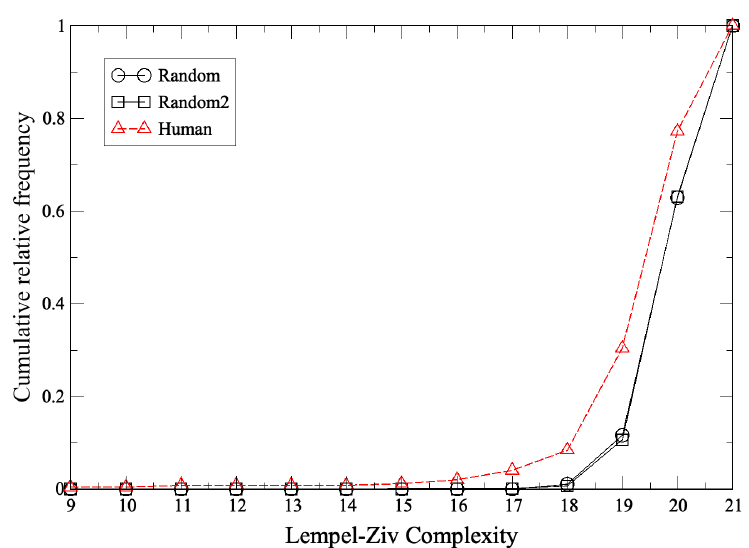
Figure 1. Cumulative frequency distribution of Lempel–Ziv complexity obtained from the set of the human RPS time series and pseudorandom series. “Random” and “Random2” are the results from the set of 500 and 10 8 pseudorandom series generated by the Mersenne Twister, respectively. As shown in Figure 2, the results from the pseudorandom series follow a normal distribution.